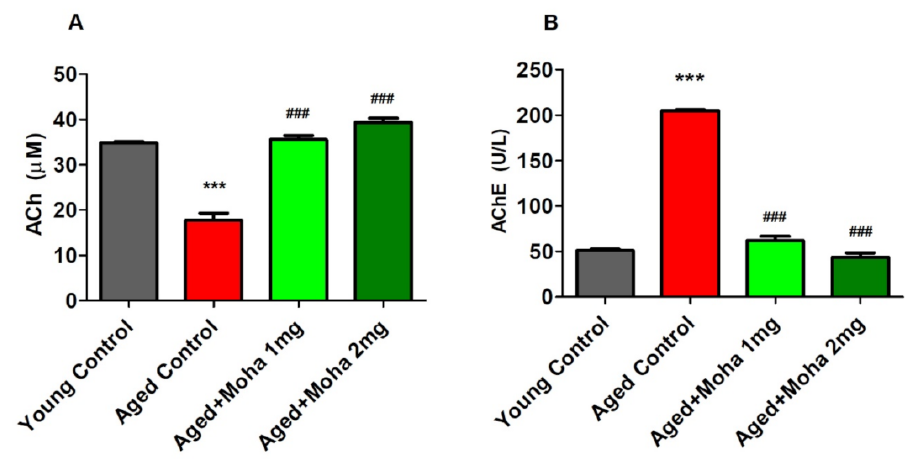
Figure 4. Effects of mahanimbine on cholinergic activity in aging mouse brain. ( A ) Comparison of the acetylcholine (ACh) level. ( B ) Comparison of the acetylcholinesterase (AChE) level. Mahanimbine treatment improved the cholinergic neuronal activities by elevating ACh levels and diminishing AChE activities. All data were expressed as mean ± SEM ( n = 6). One-way ANOVA ( F (3,20) = 85.1, p < 0.001 for ACh level and F (3,20) = 93.17, p < 0.001 for AChE level) followed by Tukey–Kramer multiple comparisons test. *** p < 0.001 in comparison with young control; ### p < 0.001 in comparison with aged